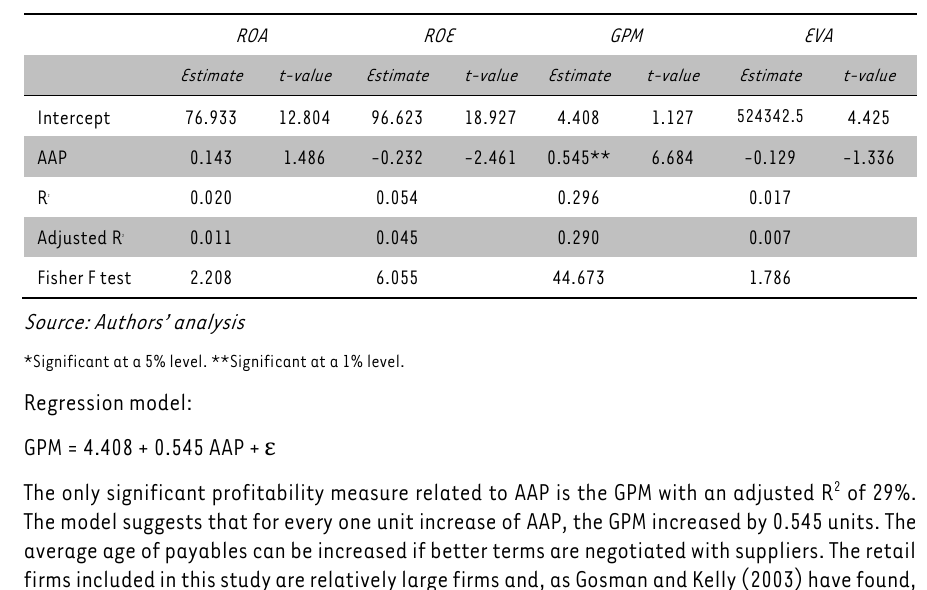
TABLE 6: Multiple regression analyses between AAP and